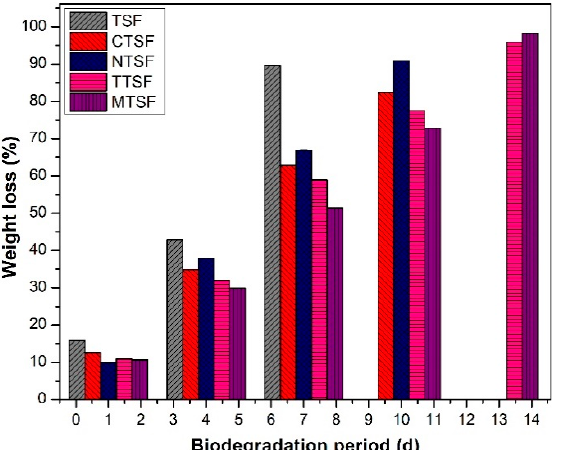
Figure 4. Biodegradability study on soil of biodegradable composite films with and without plant extracts.